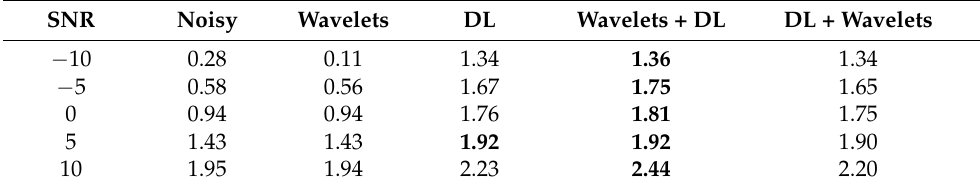
Table 6. White noise SegSNR. The higher values represent better results. In bold is the best result for each SNR level. SNR Noisy Wavelets DL Wavelets + DL DL + Wavelets − 10 − 15.74 −